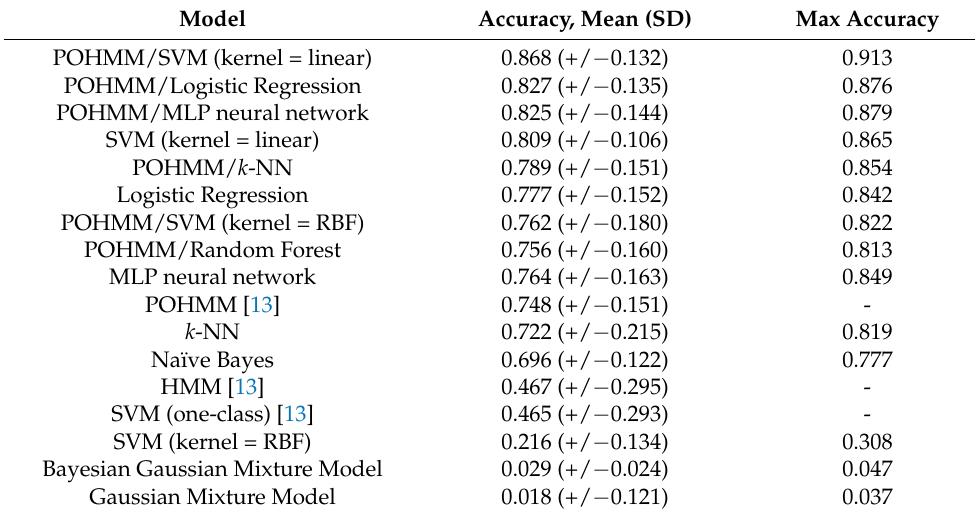
Table 4. Identification-accuracy comparison of proposed model with other models.